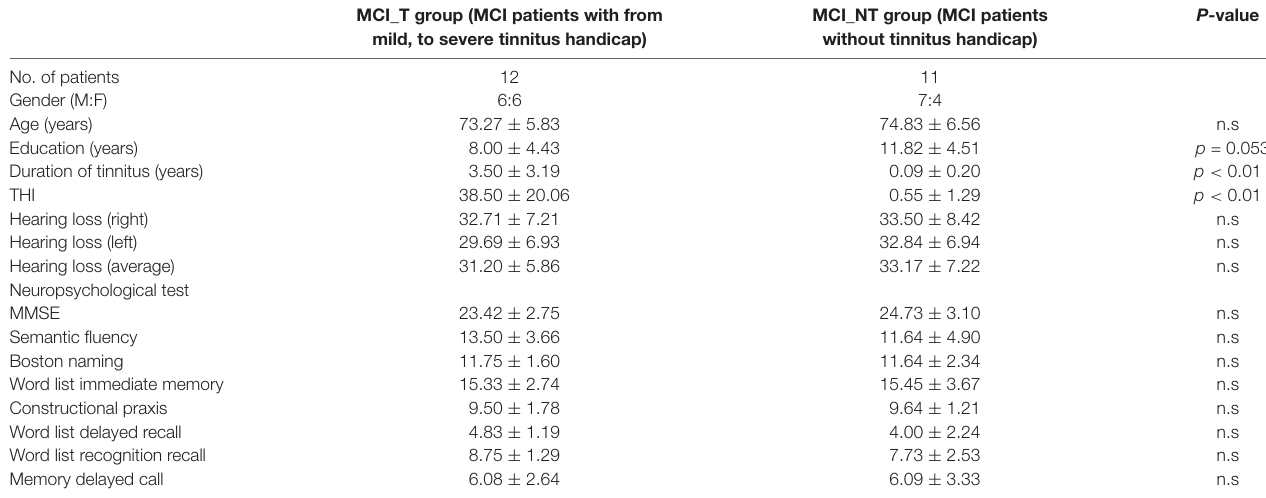
TABLE 1 | Demographic and clinical characteristics of the study population.